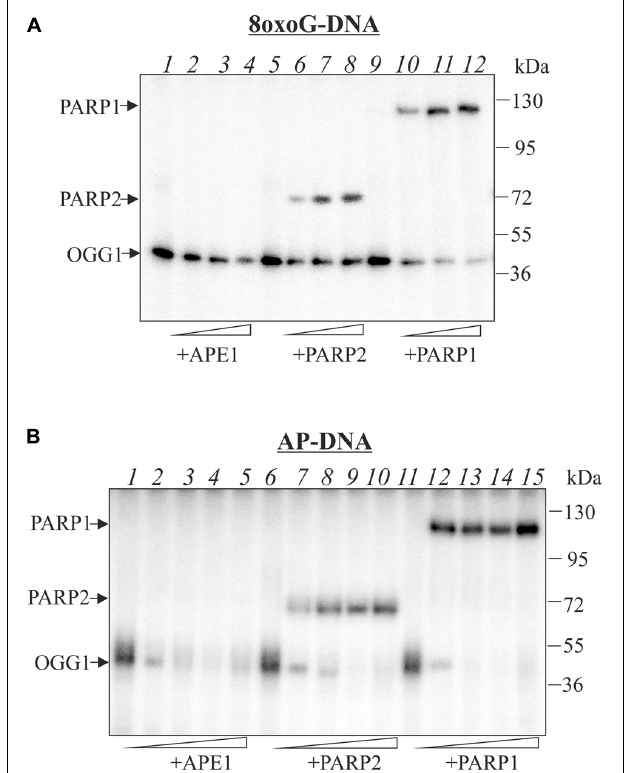
FIGURE 1 | Influence of APE1, PARP2, and PARP1 on the crosslinking of OGG1 to AP site-containing DNA. Phosphorimages of crosslinked proteins to 32 P-labeled 8-oxoG-containing DNA (A) and to AP site-containing DNA after treatment with UDG (B) . Reaction mixture included 10 nM DNA, 50 nM OGG1 and different concentrations of APE1 or PARP1/2 (50, 100, and 200 nM in A ) and (10, 50, 100, and 200 nM in B ). APE1, PARP1/2 were added to the reaction mixture simultaneously with